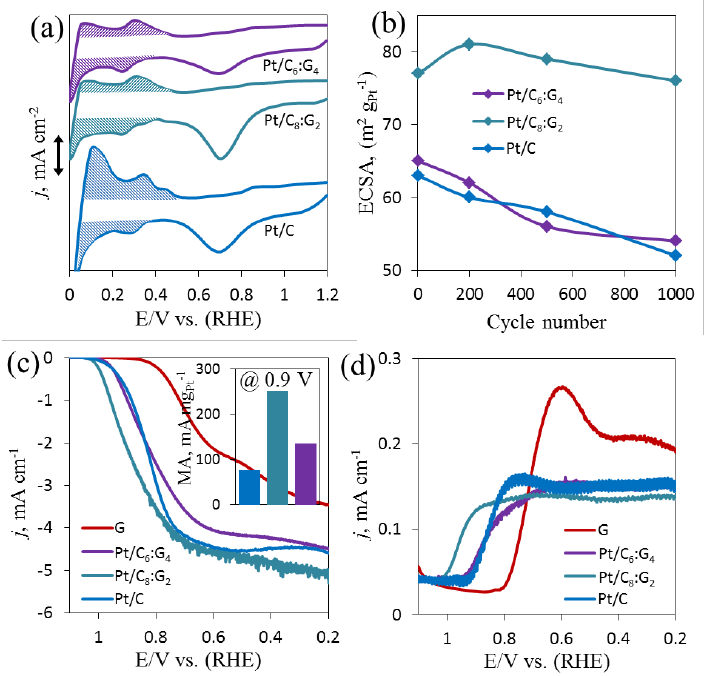
Figure 4. Cyclic voltammetry (CV) curves at a scan rate of 50 mV s − 1 (scale bar: 1 mA cm − 2 ) ( a ) and change of electrochemically active surface area (ECSA) during the accelerated durability test by CV ( b ) on Pt/C, Pt/C 8 :G 2 , and Pt/C 6 :G 4 electrodes in an Ar-saturated 0.1 M HClO 4 electrolyte, the rotating ring disk electrode (RRDE) curves for the oxygen reduction reaction (ORR) at a scan rate of 5 mV s − 1 at the disc electrode ( c ) and at the ring electrode ( d ) on above mentioned electrodes including G-sheets-modified electrodes in O 2 -saturated 0.1 M HClO 4 electrolyte. Inset: the mass activity (MA) comparison at 0.9 V (versus reversible hydrogen electrode (RHE)) for all Pt-containing electrodes.